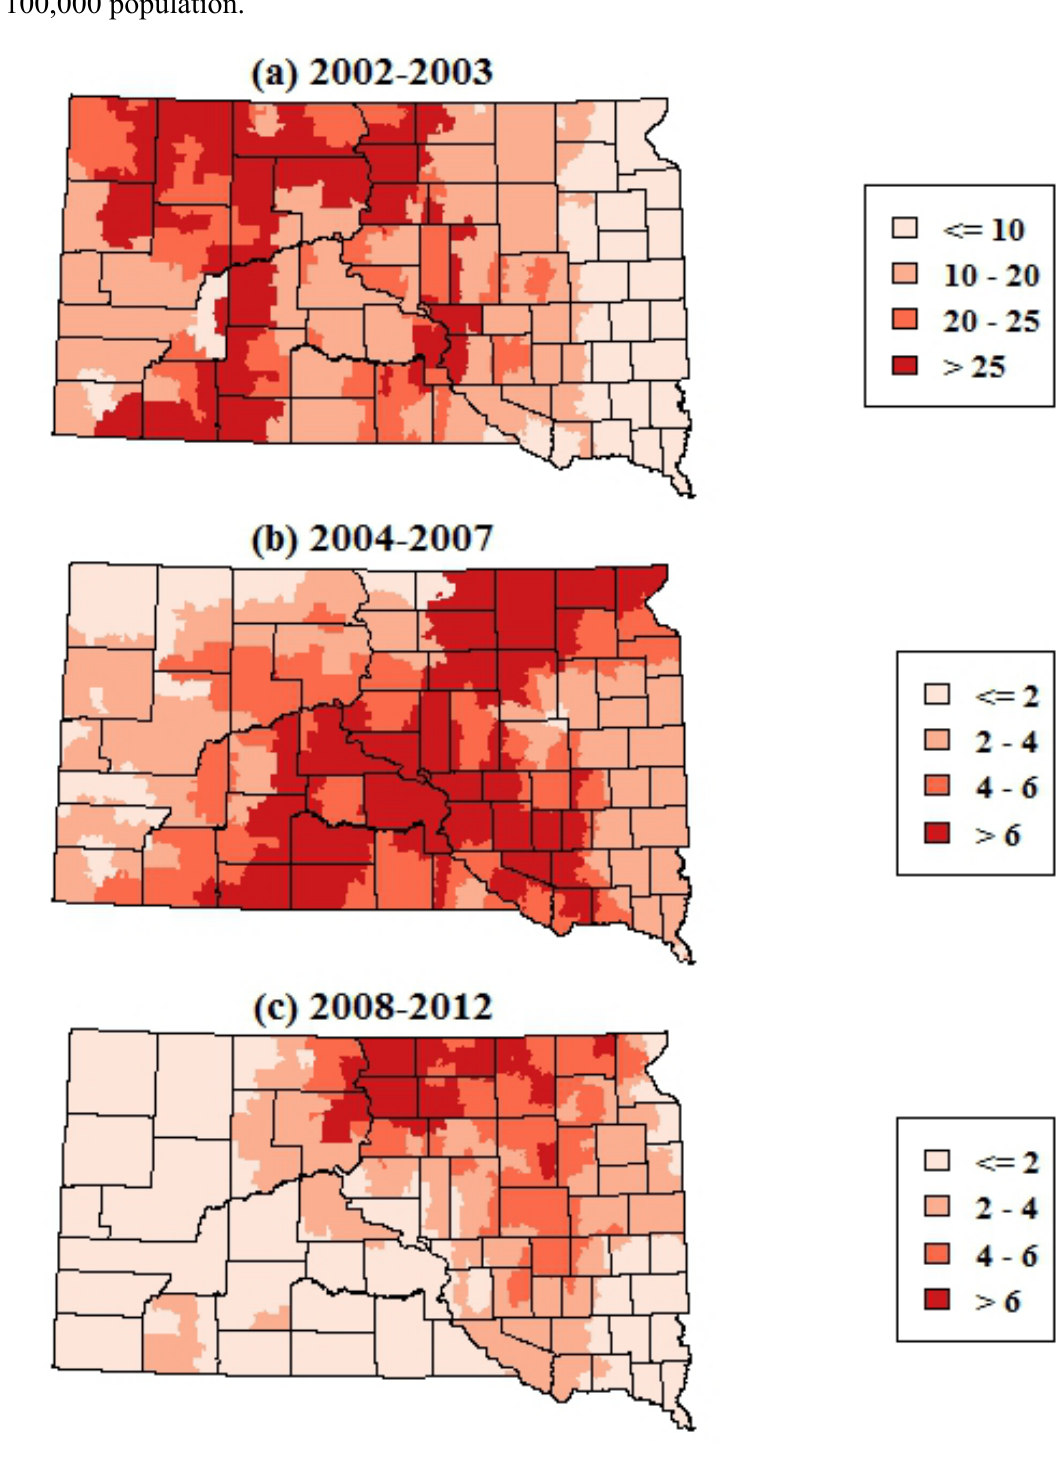
Figure 4. Spatially smoothed incidence rates of human WNV neuroinvasive disease in South Dakota for three time periods. Rates are the annual number of cases per 100,000